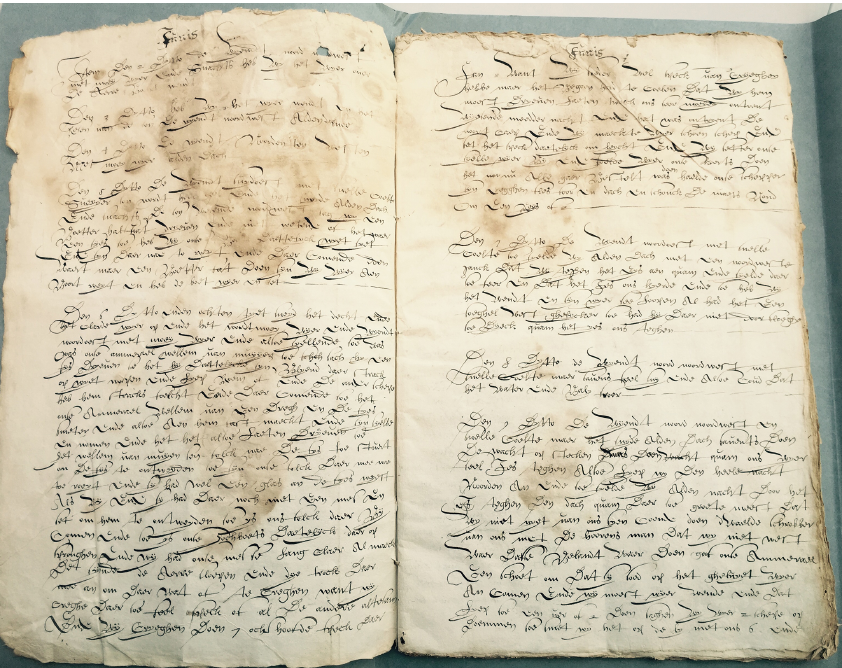
Figure 9. Journal written by a Dutch whaler during a voyage to the “Greenland Fishery”, between Jan Mayen and Svalbard, 1615. Source: 0120 Oud archief stad Enkhuizen 1353–1815 (1872), Westfries Archief,